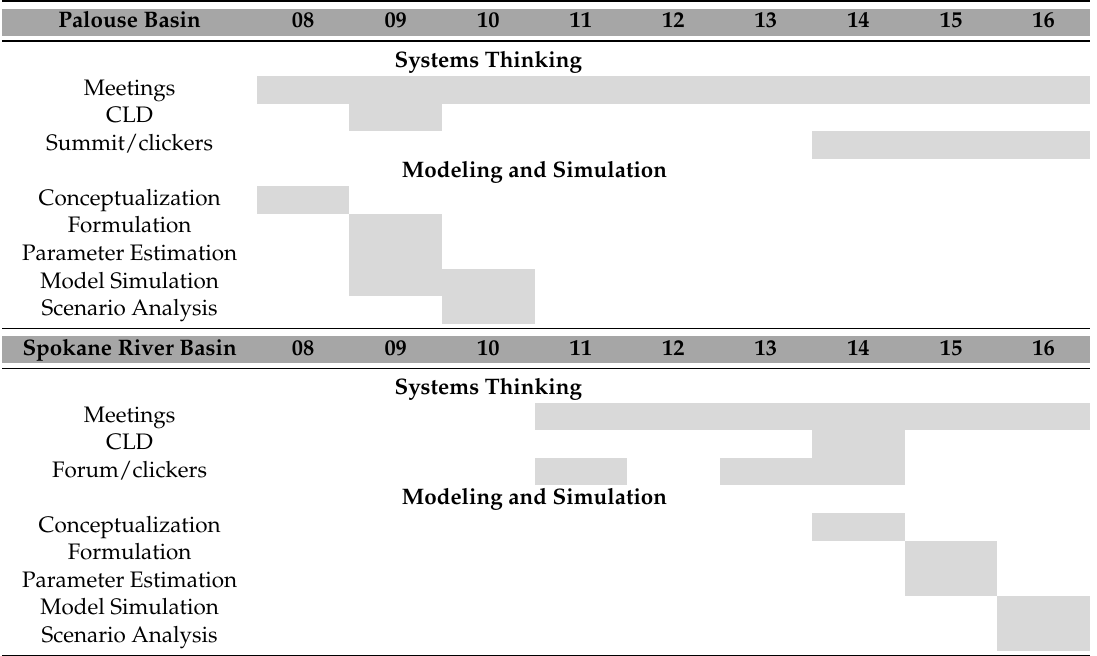
Table 1. Engagement activities over time in the Palouse and Spokane basins (2008 to